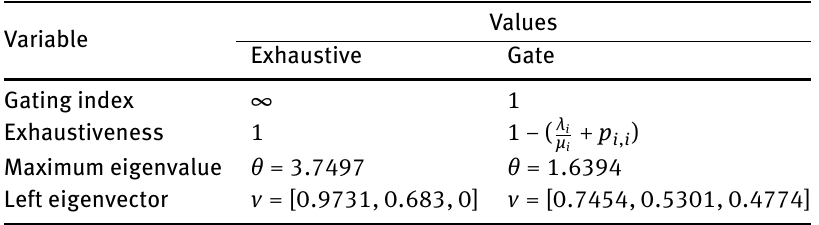
Table 2: Essential variable values in 3-queue polling